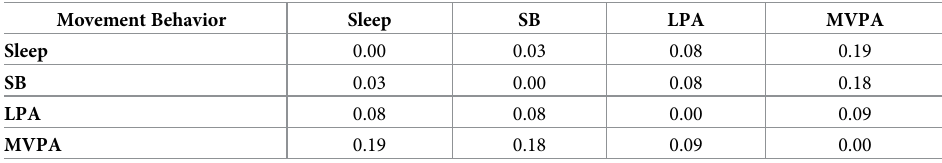
Table 3. Pair-wise log-ratio variation matrix for the movement behaviors. Movement